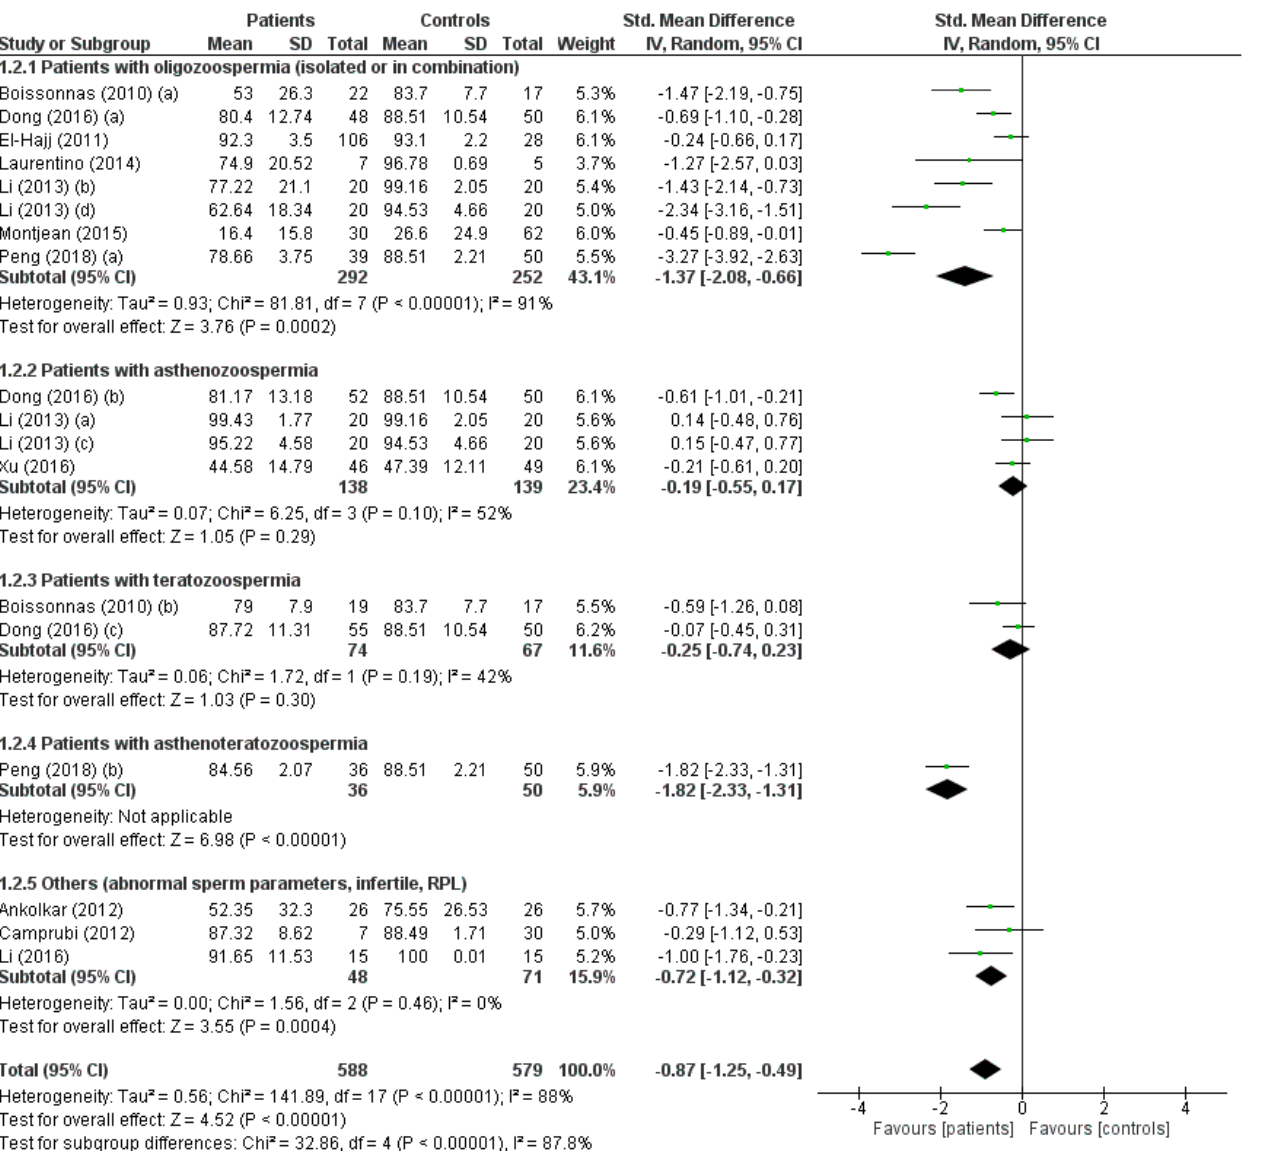
Figure 2. H19 gene methylation in spermatozoa of patients with infertility/abnormal sperm param- eters and controls. The studies meta-analyzed are: [21–30,34]. Meta-regression analysis showed that the difference in the H19 methylation pattern be- tween the patients and controls was independent of both age and sperm concentration (Figure